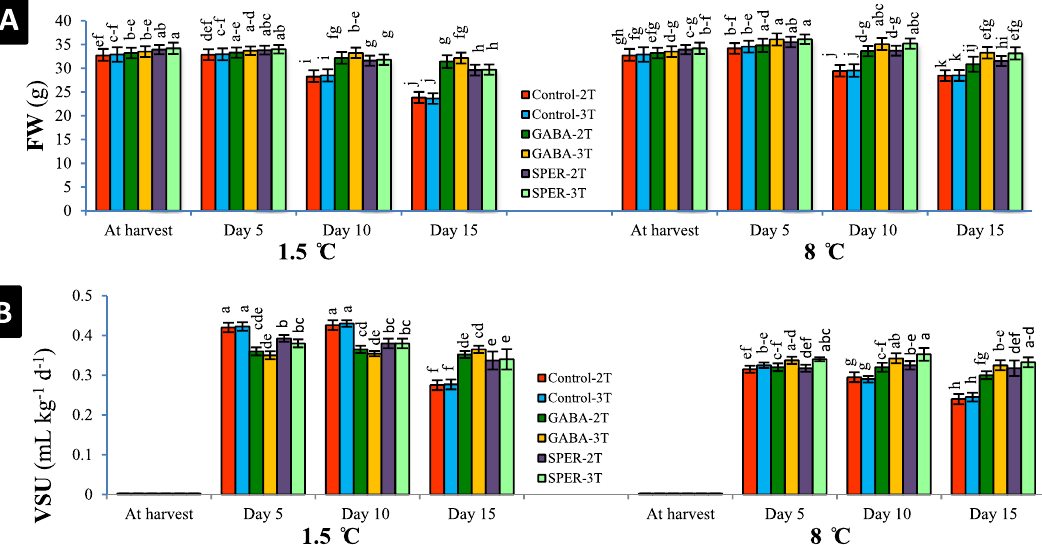
Figure 3. Effect of pre-harvest GABA and SPER spray on the fresh weigh (FW ) ( A ) and vase solution uptake (VSU) ( B ) of gerbera ‘Stanza’ cut flowers during cold storage at 1.5 °C and 8 °C. 2 T and 3 T represent number of times the GABA and SPER are sprayed on intact gerbera plants at pre-harvest. Values are mean SE, n = 4. The bars marked with the same letters are not significantly different at p < 0.05.